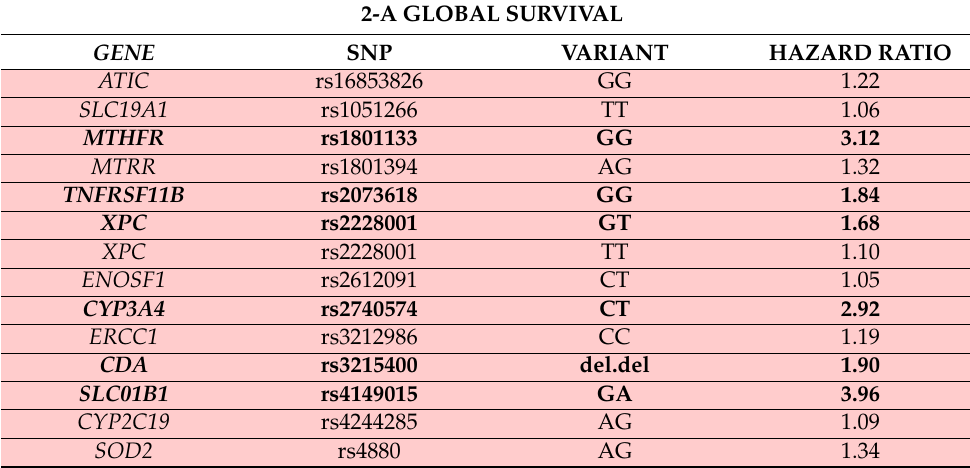
Table 2. Polymorphisms associated with survival variation. The associations of SNP variants with protective effects are shown in green, and those with an increased probability of a lower survival rate are shown in red. Panel 2-A shows the results according to overall survival, and Panel 2-B shows the results according to event-free survival. Bold-type values are those over 1.50 or under